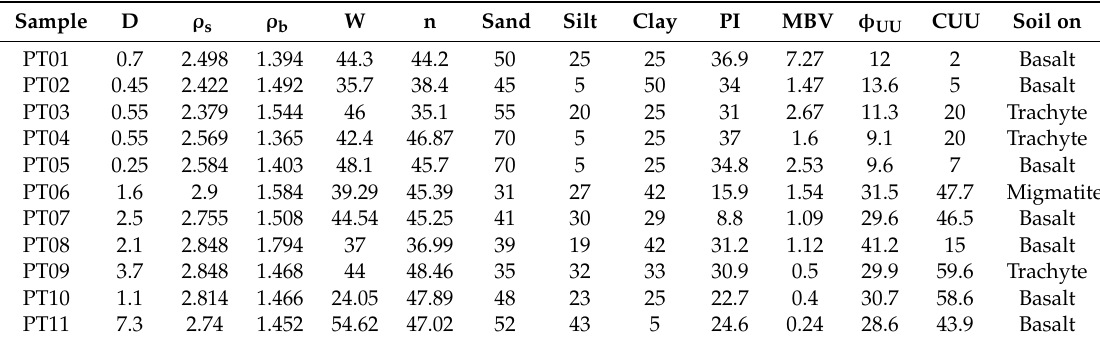
Table 2. Geomechanical properties of soil